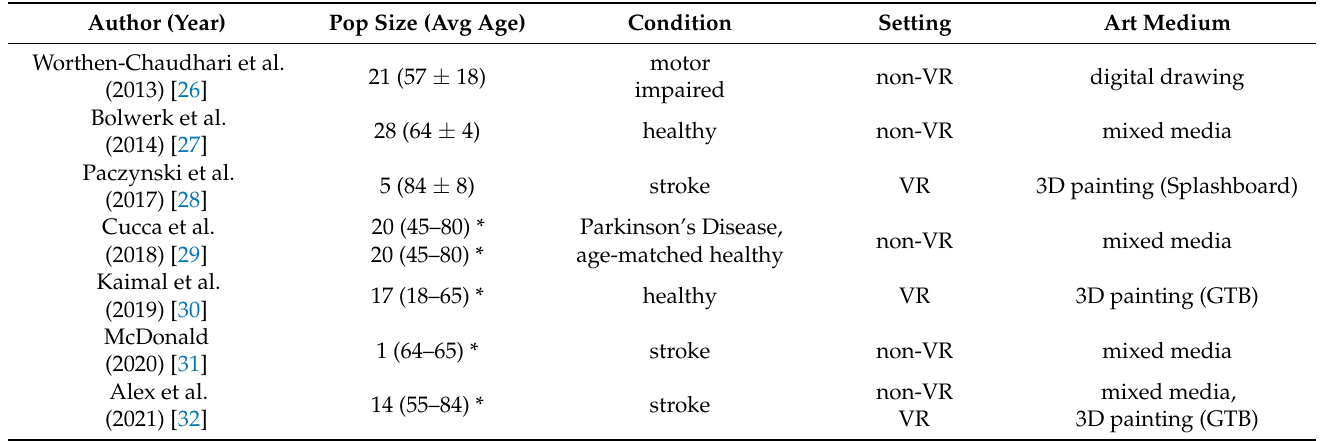
Table 1. Diversity of the reviewed